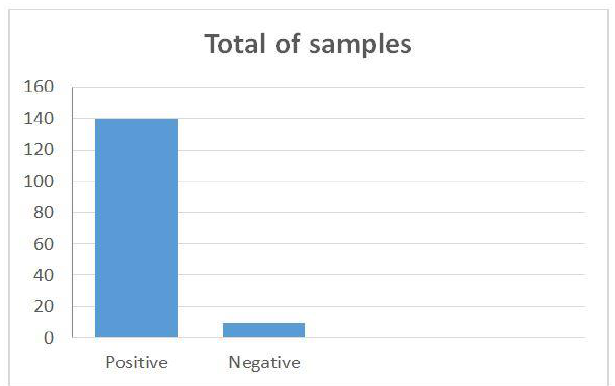
Fig. 1: Total of samples positive and negative bacterial isolates.